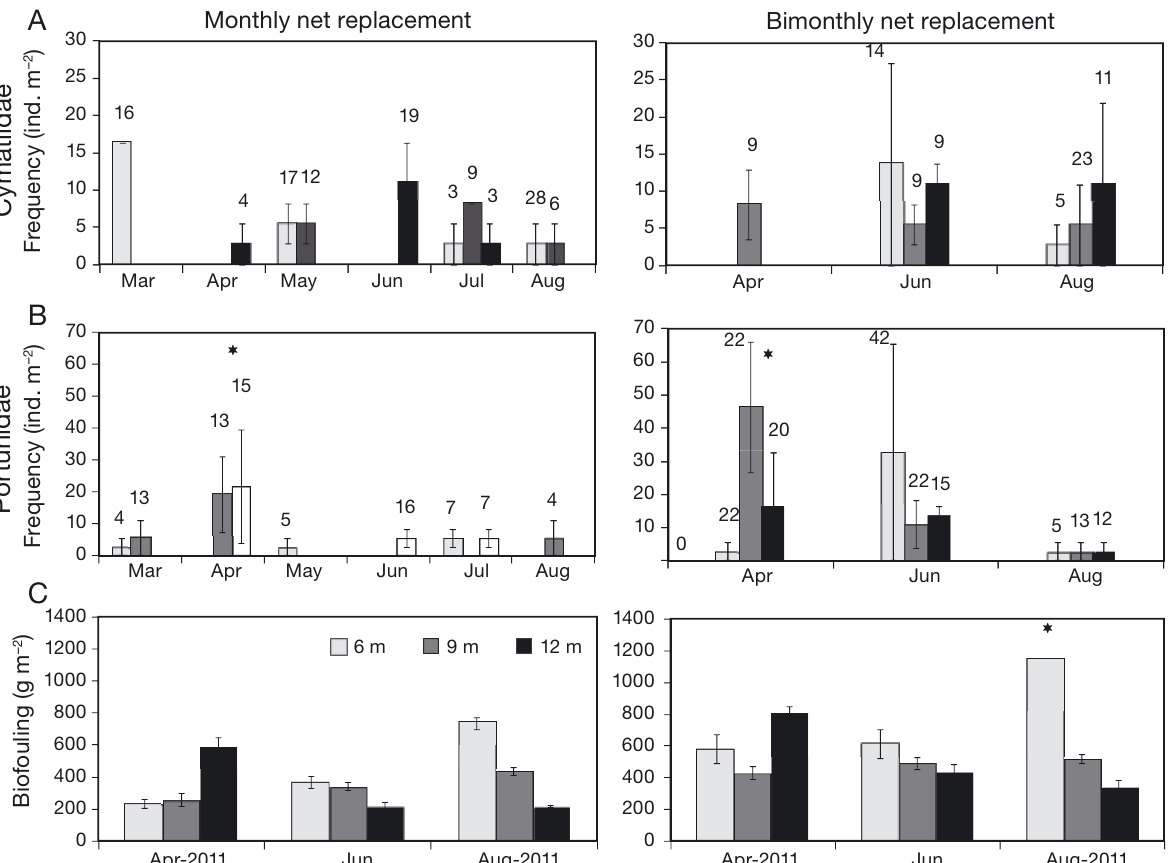
Fig. 3. Mean ± SE frequency of presence and size of the predators (A) Cymatiidae and (B) Portunidae inside the pearl nets with Argopecten nucleus and (C) biofouling dry biomass in the nets under different conditions (i.e. culture depths and net replace- ment frequencies). Numbers above bars represent the predator size means in mm (shell length for cymatid snails and carapace width for portunid crabs). *p < 0.05